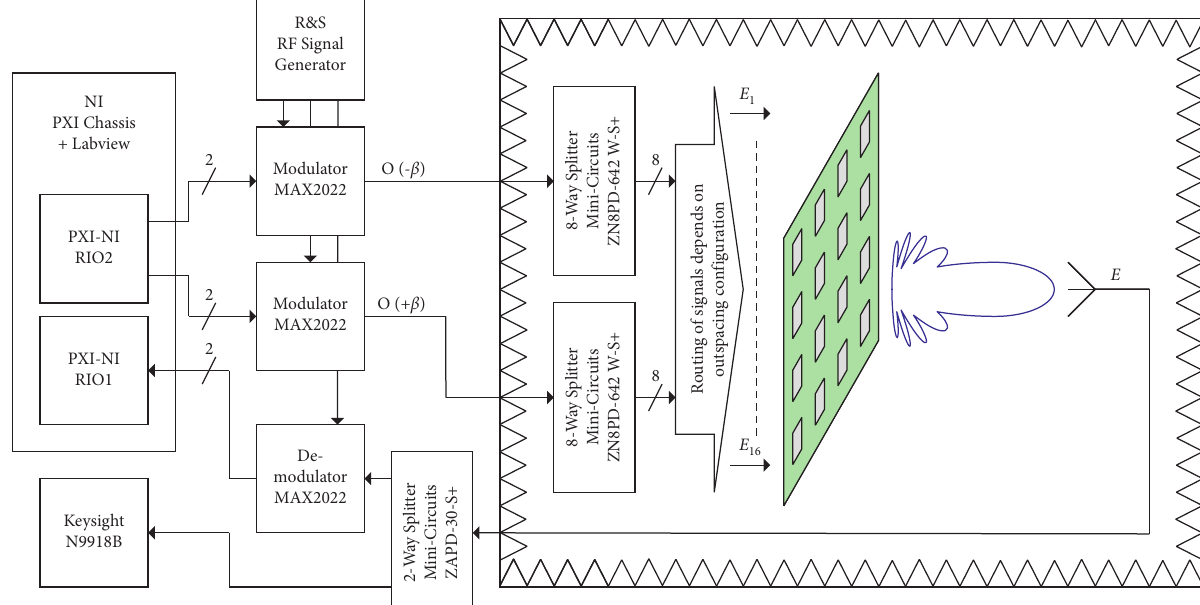
Figure 12: OTA measurement setup for measuring the outspacing behavior in an anechoic test